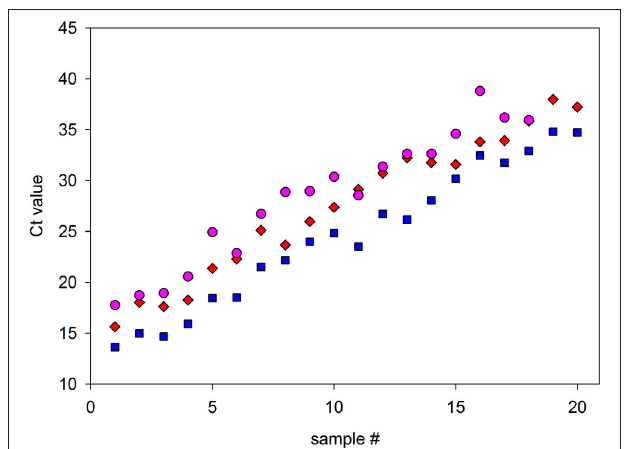
FIGURE 2 | Comparison of RT-qPCR detection of selected samples alone or in pools, and assessment of stability after freezing and thawing. Twenty representative samples with a range of Ct values were subjected to RT-qPCR alone or diluted in 1:20 with negative samples and measured. After dilution, 18 of the 20 samples were detected, while two samples, which possessed the highest Ct values, were not. Red diamonds: Ct values of the samples measured alone (N gene, GeneFinder kit). Pink circles: Ct values of the 1:20 pool. In parallel, Ct values for the same samples measured alone were obtained after freezing and thawing to observe their stability (blue squares). These last two measures were from N gene performed with DisCoVery kit. The average 1 Ct value due to the dilution for the measurements at the same run was 4.95, close to the theoretical value